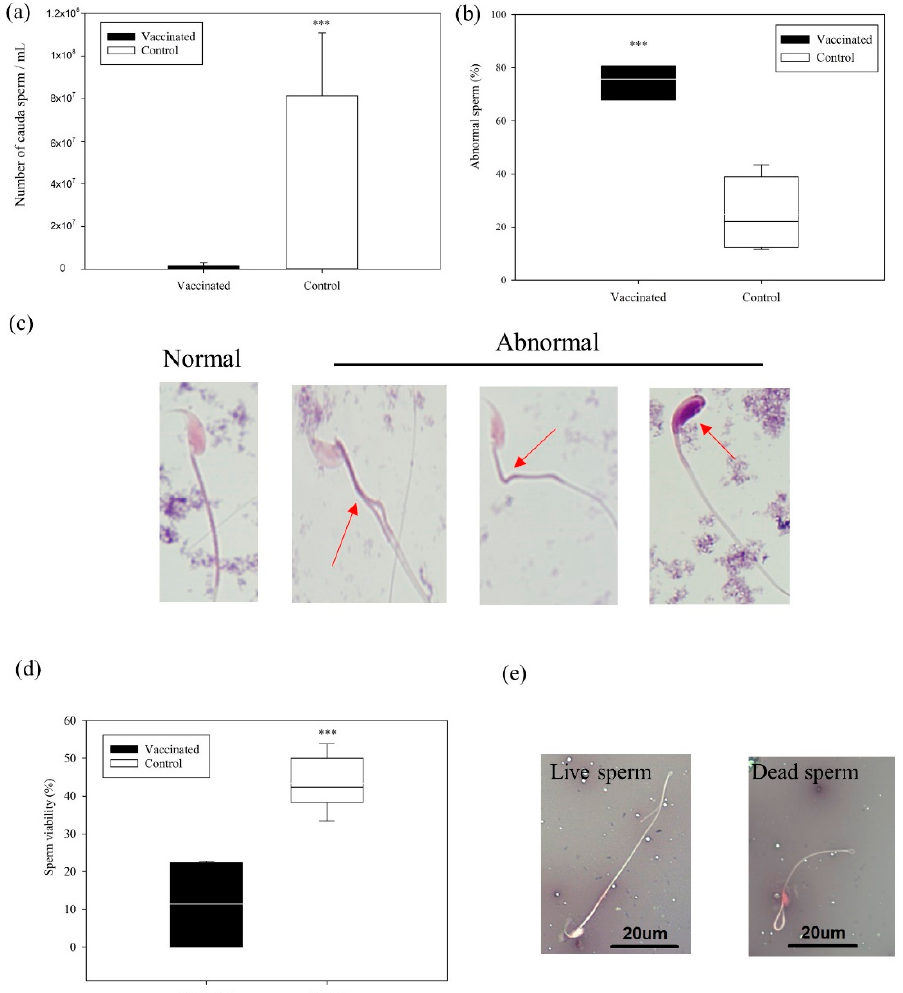
Figure 5. Sperm count, abnormality, and viability in the vaccinated and control groups. ( a ) Sperm count (Mean ± SD). ( b ) Percentage of abnormal sperm in the vaccinated (75.8% ± 7%) and control groups (29.3% ± 17%) (Mean ± SD). ( c ) A high percentage of oval heads and split or divided necks were observed in the sperm in the vaccinated group. ( d ) Percentage of sperm viability in the vaccinated (11.4% ± 11%) and control groups (43.1% ± 6.5%) (Mean ± SD). ( e ) Live and dead